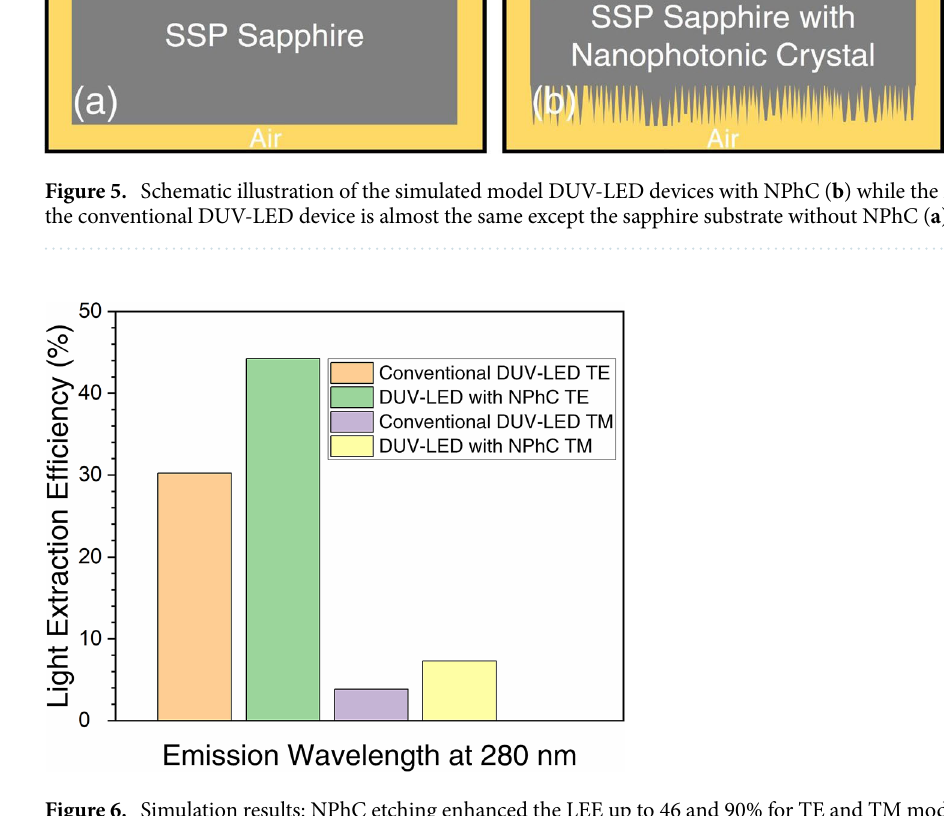
Figure 6. Simulation results: NPhC etching enhanced the LEE up to 46 and 90% for TE and TM modes, respectively, relative to the conventional DUV-LED